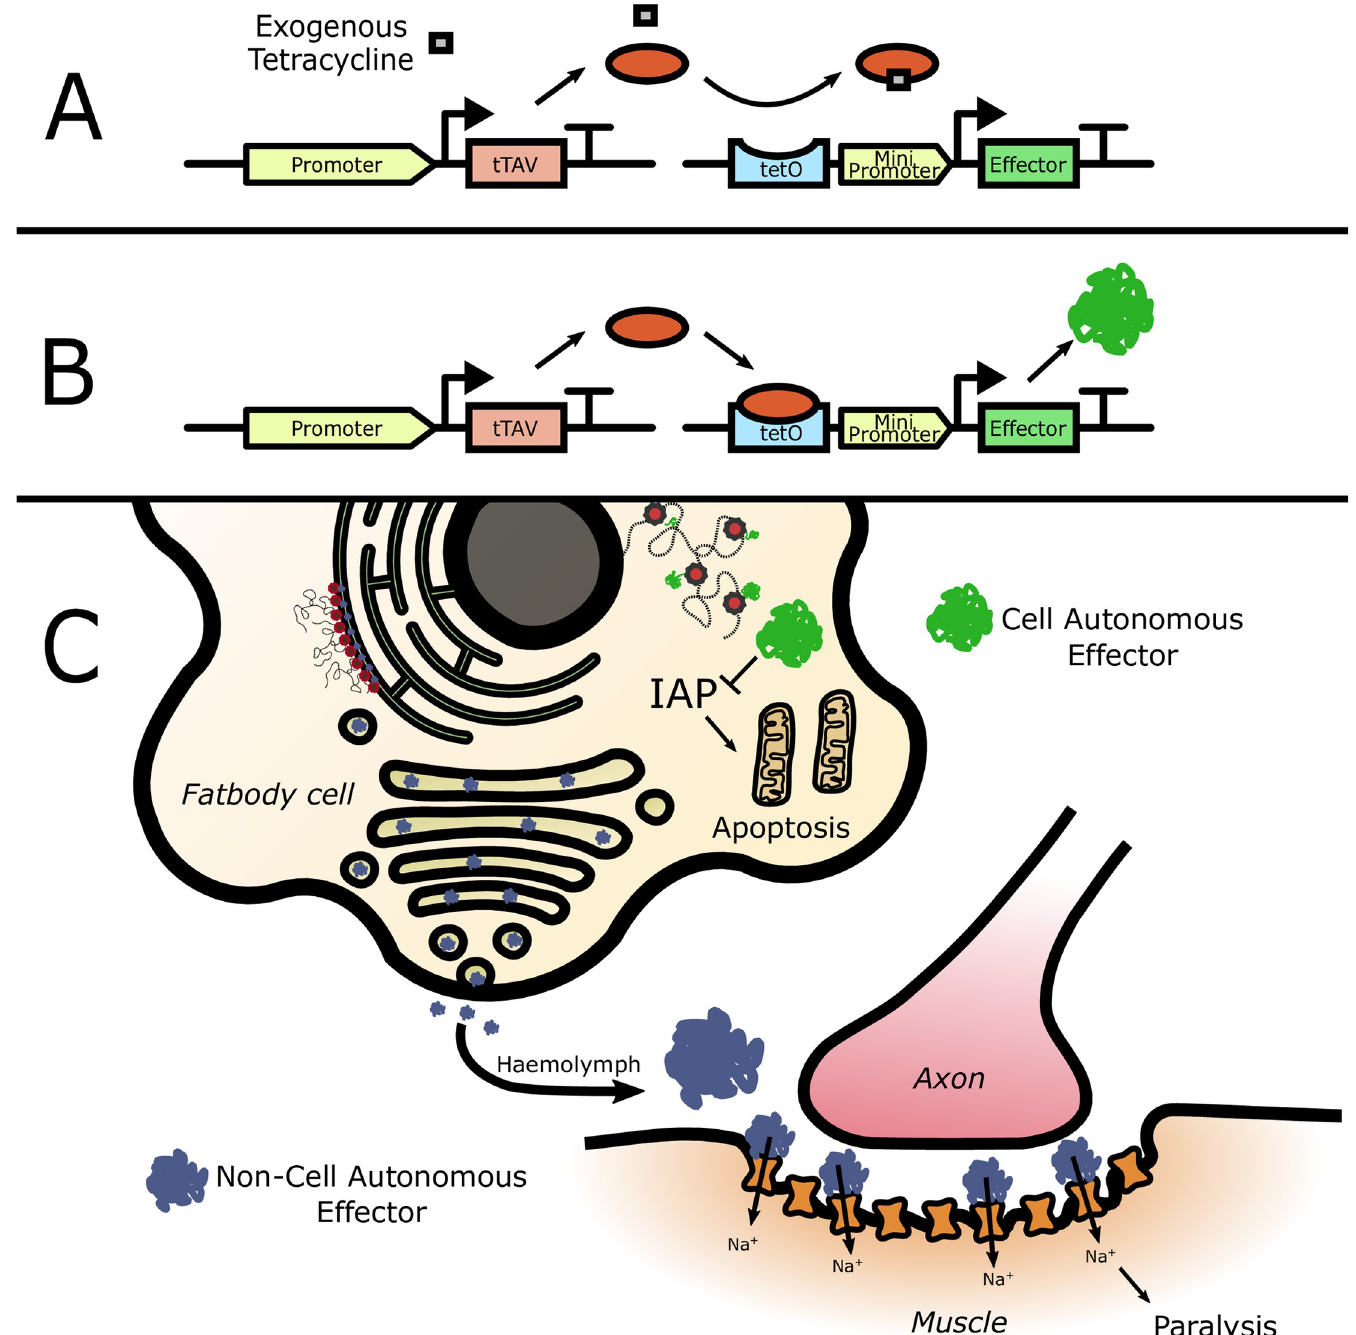
Fig 1. Schematic representation of the tet-off bipartite expression system and the use of cell-autonomous and non-cell autonomous effectors. A, B: The tet-off bipartite gene expression system. As used here, the system is divided into two genes carried by two independent transgenic lines. The ‘driver’ line will express the synthetic transcriptional activator tTAV under the spatial and temporal expression pattern of the promoter chosen to drive it (here from VitellogeninA1). The ‘effector’ line carries an effector open reading frame (here Michelob, Reaper KR or AaHIT) under the transcriptional control of the tet operator (the binding site for tTAV protein). A: System in a suppressed state. Tetracycline (shown as a grey square) binds to the tTAV protein and prevents its binding to tetO, therefore, suppressing the expression of the downstream effector. B: System in an unsuppressed state. In the absence of tetracycline, tTAV will bind to tetO and stimulate expression of the effector. C: Comparison of the mode of action of cell autonomous and non-cell autonomous effectors. For the cell autonomous effector, mRNA leaving the nucleus is translated on ribosomes in the cytoplasm leading to protein which then sets off an intracellular pro-apoptotic cascade (as is the case for Reaper KR and Michelob). For the non-cell autonomous effector secretory peptide signals (here gp67) lead it, instead, to be translated on ribosomes studding the endoplasmic reticulum (ER) and pass through the